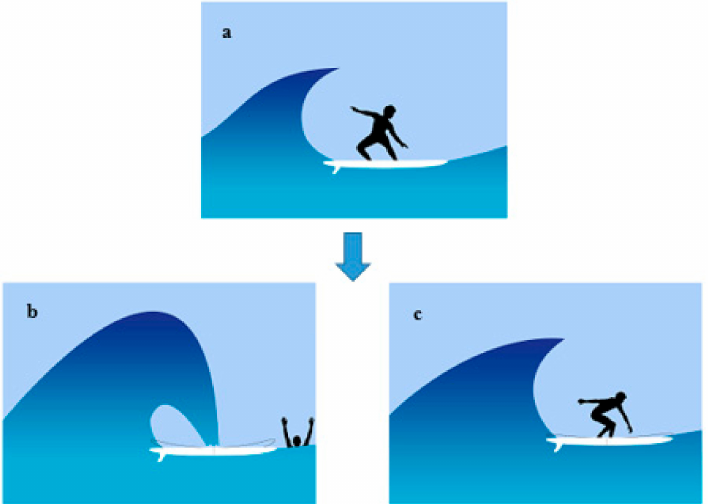
Figure 7. A schematic of the most common situations that boards break: ( a ) A standard boarding with a fine distance between the rider’s feet; ( b ) when the wave hits on the board while the rider falls in the water; ( c ) when the rider’s feet get so close together that the weight of their body is concentrated in the middle of the board.